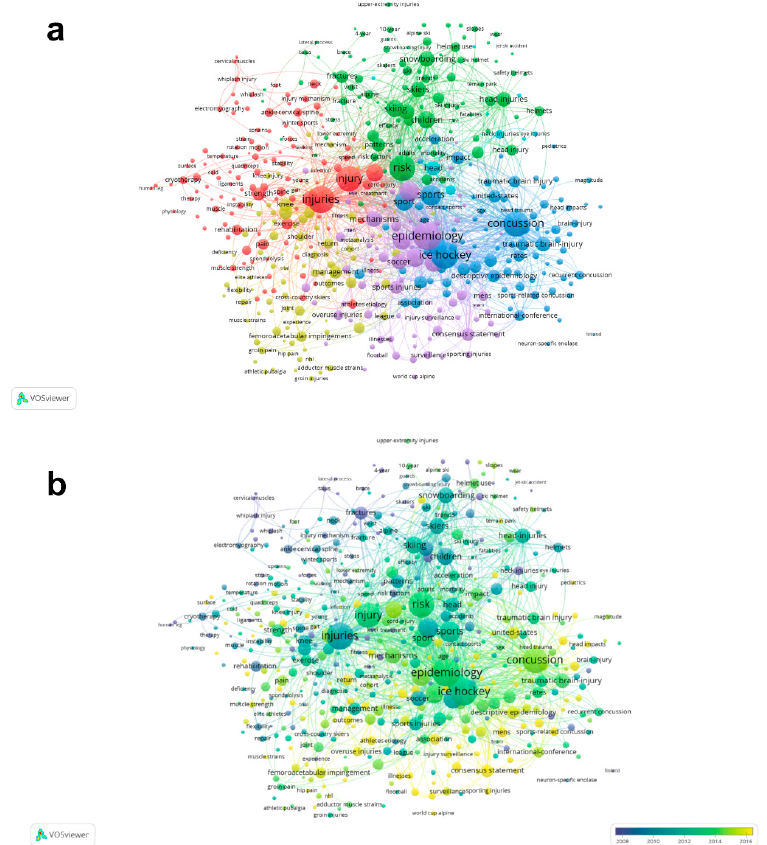
Figure 4. Co-occurrence analysis of global research about ice and snow sports injuries. ( a ) Network visualization mapping for the 233 identified items. Five main clusters were identified: injuries study (red color), head and neck damage study (blue color), risk study (green color), therapy study (yellow color) and epidemiology study (purple color). The size and distance of the nodes indicate the frequency and relationship of items. ( b ) Overlay visualization mapping for the 233 identified items used to show development trends over time.